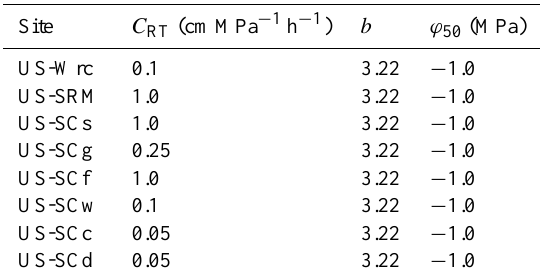
Table 4. Parameters used in the HR scheme of Ryel et al. (2002) for the study sites. “ C RT ” is the maximum radial soil − root conduc- tance of the entire active root system for water, “ ϕ 50 ” is the soil water potential where conductance is reduced by 50%, and “ b ” is an empirical